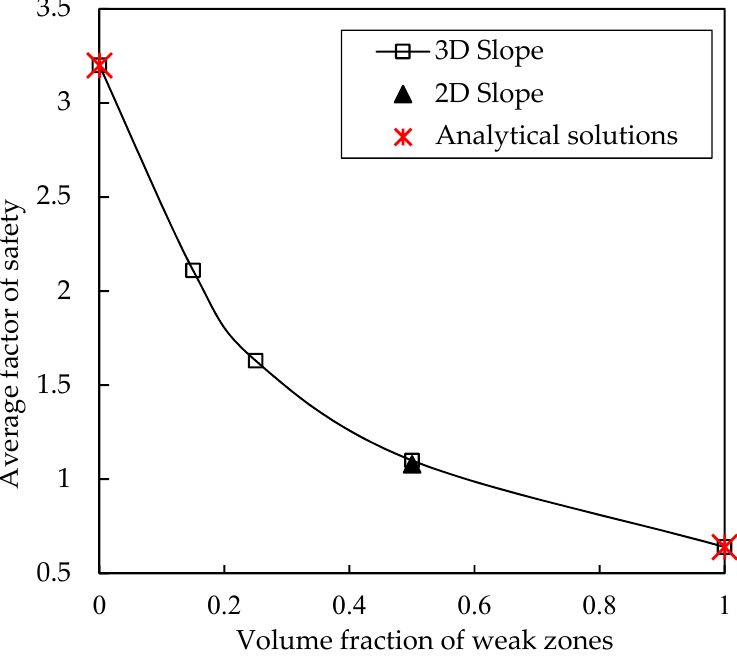
Figure 9. Validation of proposed method by considering a rock-soil slope stability problem. At the same time, it can be seen from Figure 9 that when the slope contains weak zones, the safety factor is 0.64, and when the slope is composed of rocks, the safety factor is 3.2 (the simulation results are consistent with the analytical solution). The median safety factor of slopes with weak zones and rocks is 1.92, which is greater than the safety factor of 1.14 obtained when the volume fraction of weak zones is 50%, meaning that the failure mechanism of slopes with weak zones may be dominated by weak zones. To study the failure principle of slopes with weak zones, Figure 10 shows the plastic strain diagrams of homogeneous slopes and slopes with weak zones. It can be seen from the figure that the homogeneous slope forms an obvious overall shear failure zone. In the slope with weak zones, due to the existence of the weak zones, a series of small shear failure zones appear in the failure mode of the slope along the laminar tendency. These small plastic strain regions reduce the safety factor of the slope.